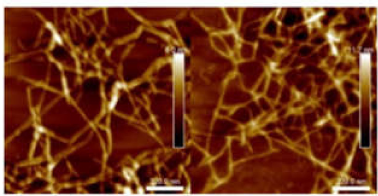
Figure 1. Atomic force microscopy (AFM) images of L-toCNF (left) and H-toCNF (right). toCNFs: TEMPO-oxidised cellulose nanofibrils. L and H are low and high contents, respectively.